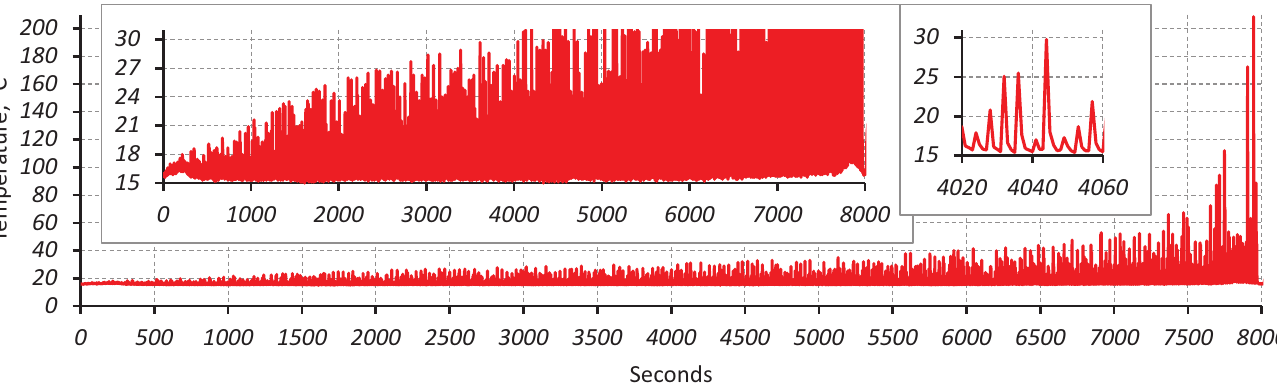
Figure 6. Temperature history of the ultrasonic fatigue test that lasted 4 million cycles at 400 MPa stress